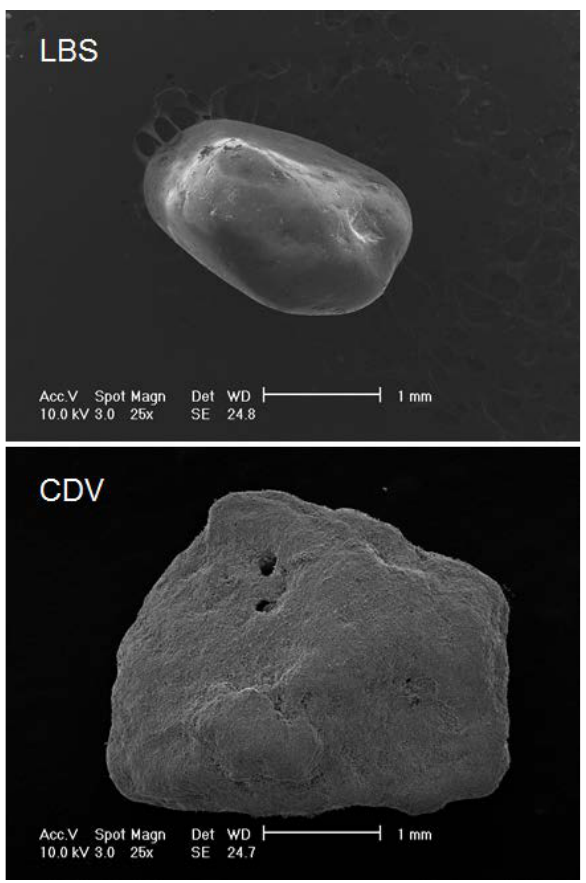
Figure 1. Scanning electron microscope images of LBS grain ( top ) and CDV granule ( bottom ) indicating their outline.